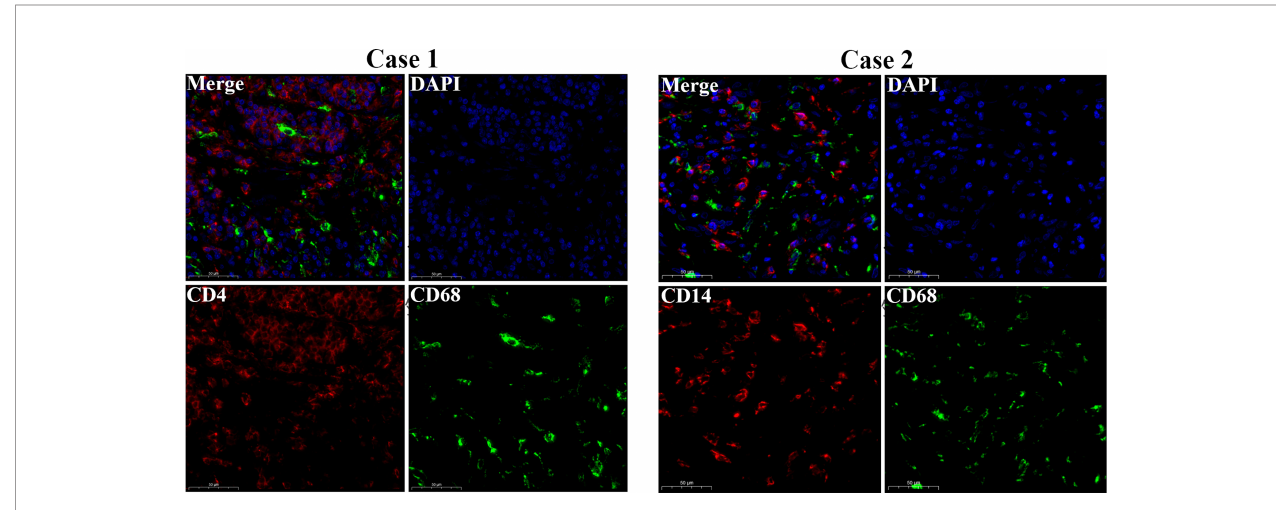
FIGURE 3 | Gene microarray immuno fl uorescence double staining. Double immuno fl uorescence staining for CD14 (red) and CD68 (green) antigens of tumor cell. Scale bars = 50